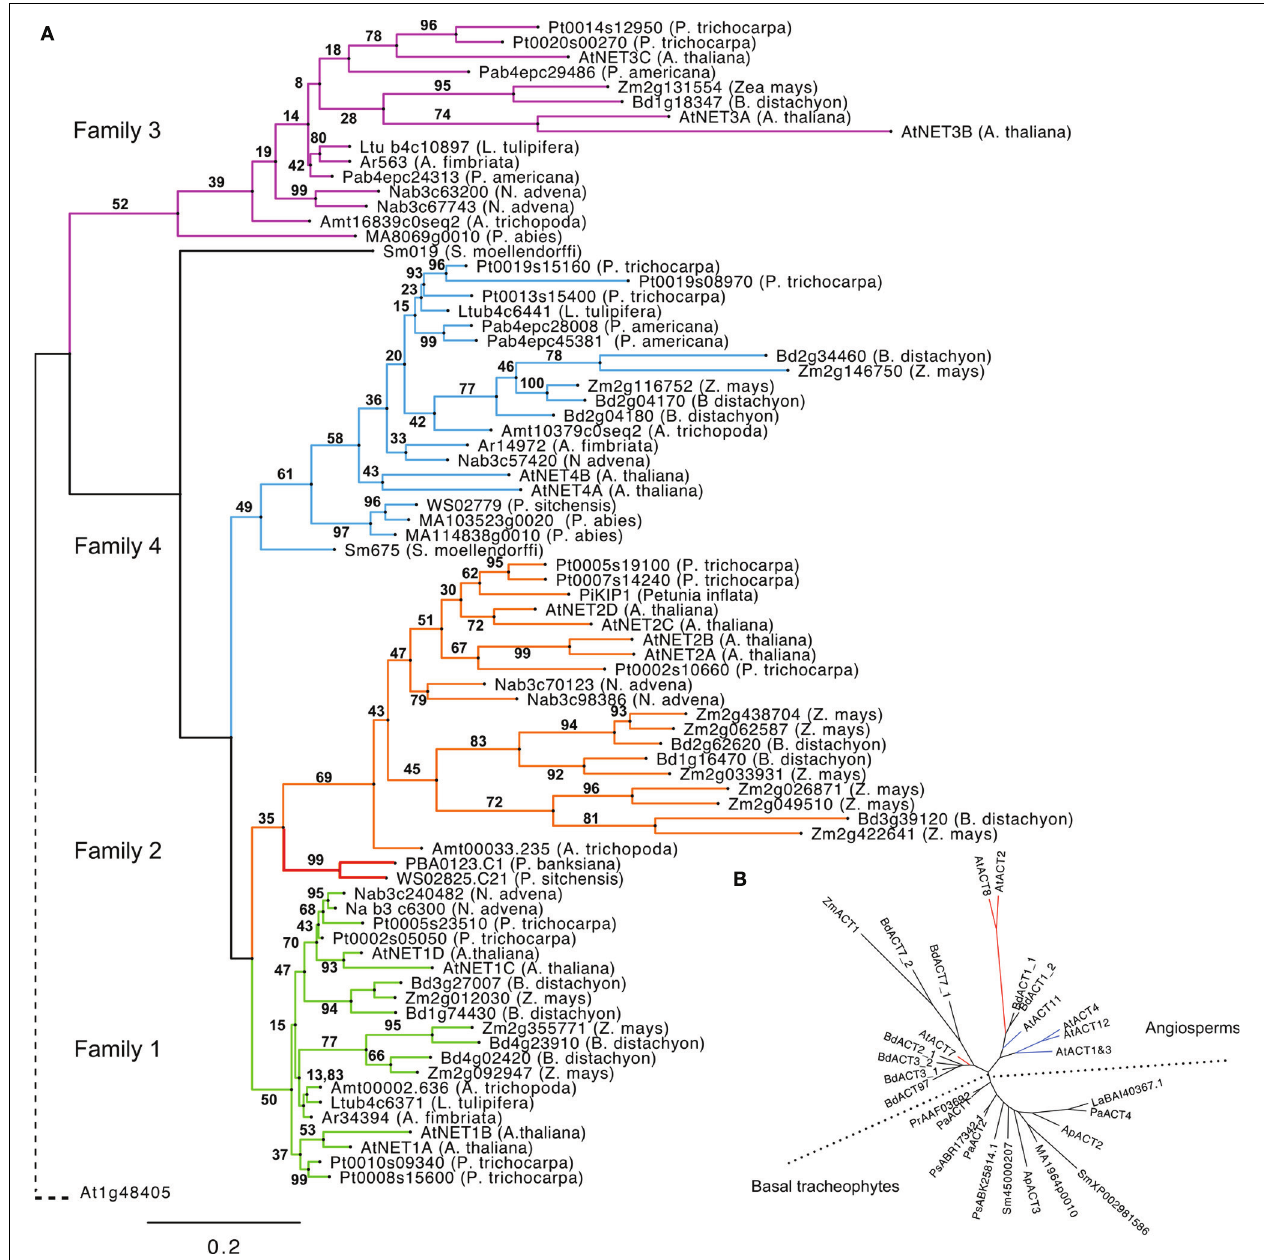
FIGURE 2 | (A) Phylogeny of NET proteins calculated from the alignment of NAB domains. Branches are colored according to NET family. Gymnosperm 1/2 hybrid forms are separate in red. The phylogeny is rooted using the NAB-like N terminus of Arabidopsis